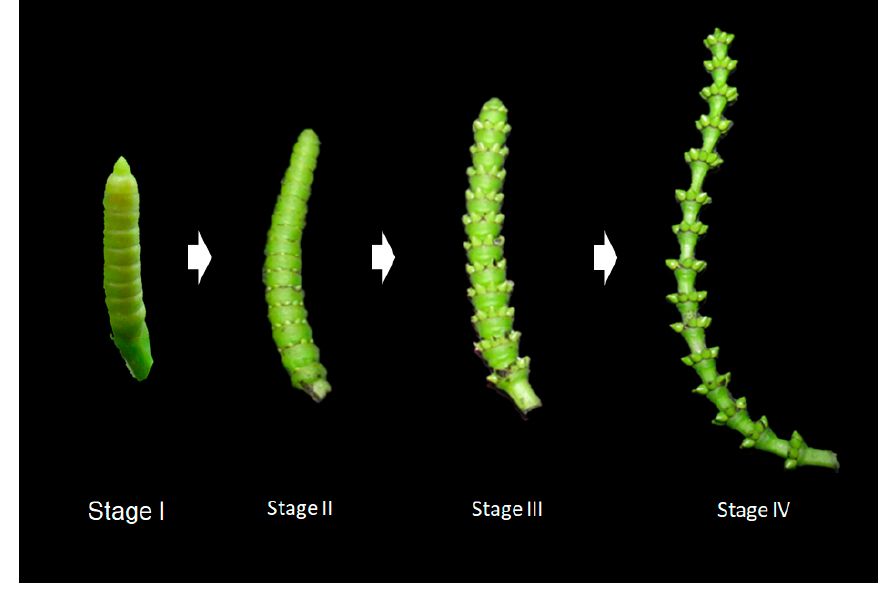
Figure 1. Different developmental stages of female strobili in Gnetum luofuense C.Y.Cheng . Figure 1. Di ff erent developmental stages of female strobili in Gnetum luofuense C.Y.